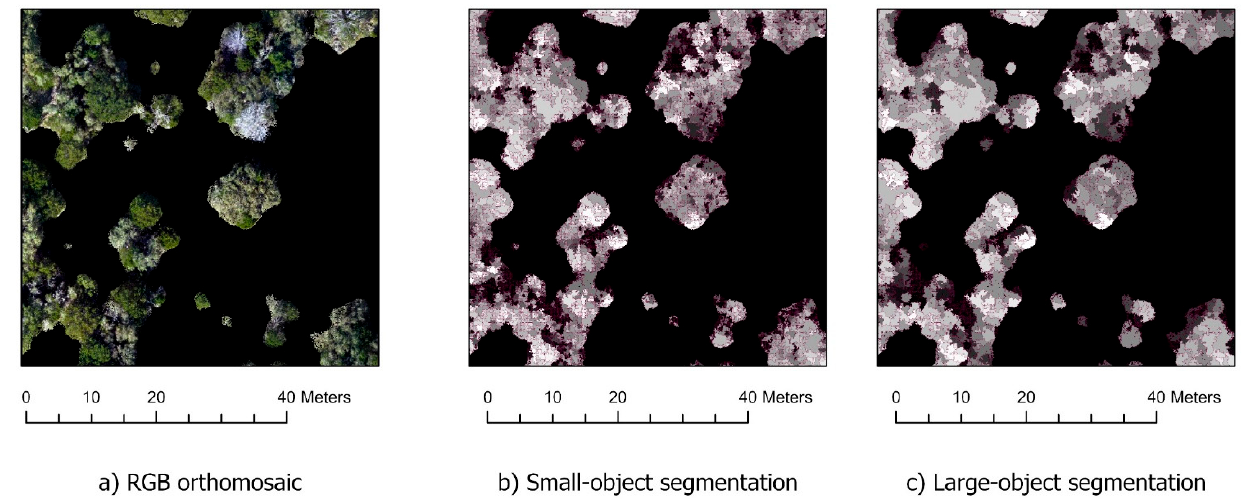
Figure 5. A display of the two segmentations performed on the orthomosaic. ( a ) The 10 cm orthomo-